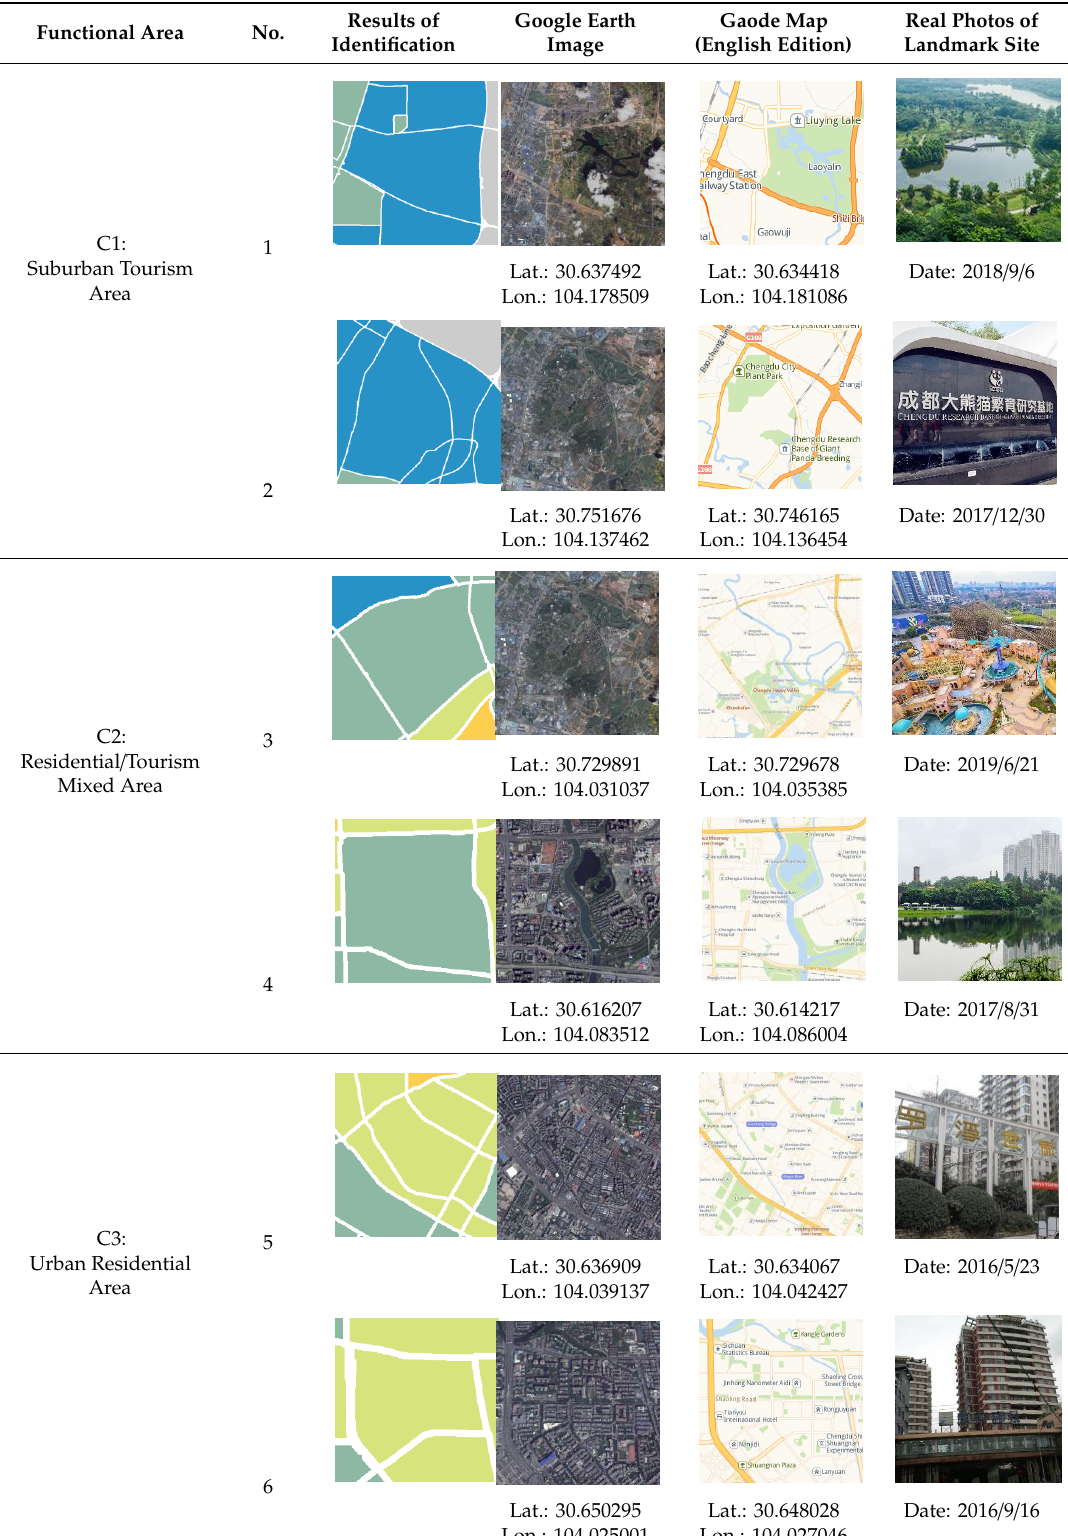
Table 2. Comparison and evaluation of functional area identification results.